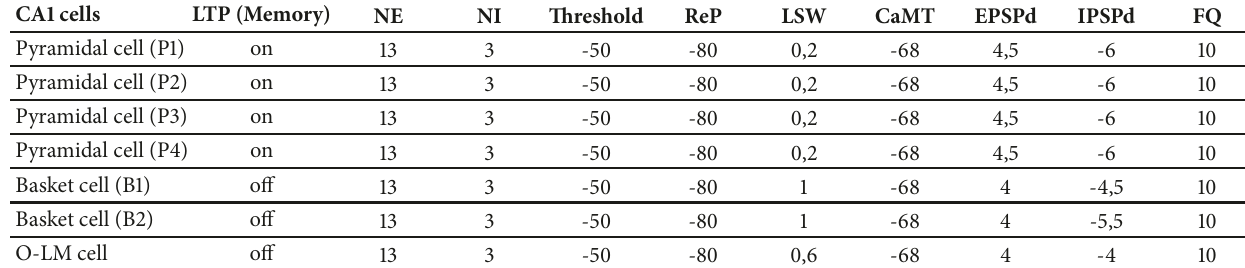
Table 2: Initial parameters microcircuit model of CA1